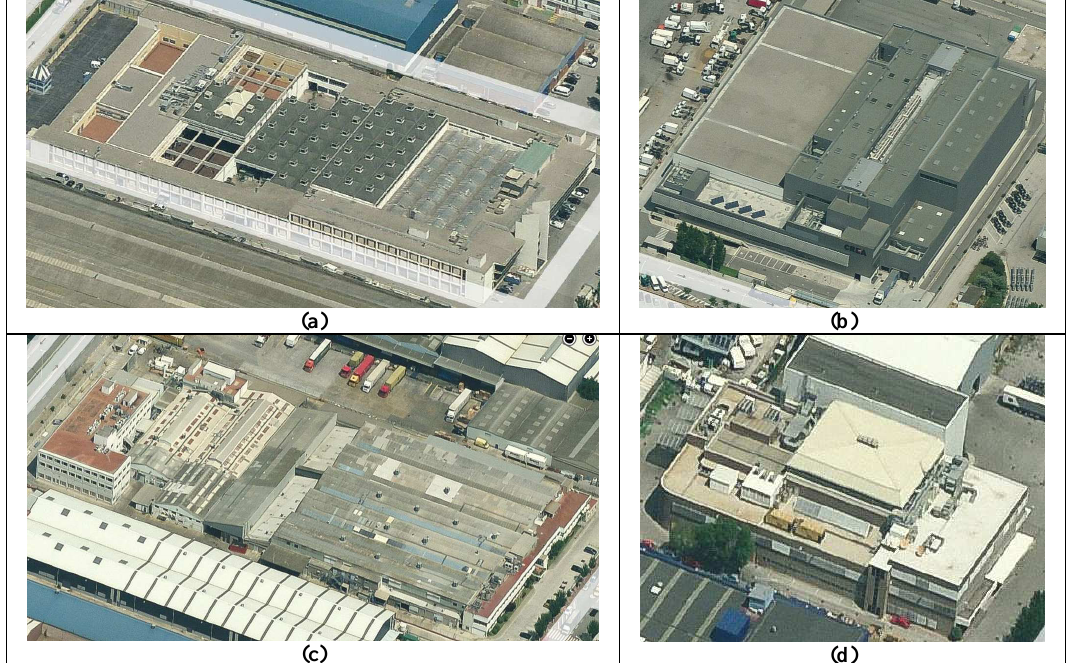
Figure 6. Oblique views of buildings 4 (a), 8 (b), 33 (c), and 38 (d) (Bing map,